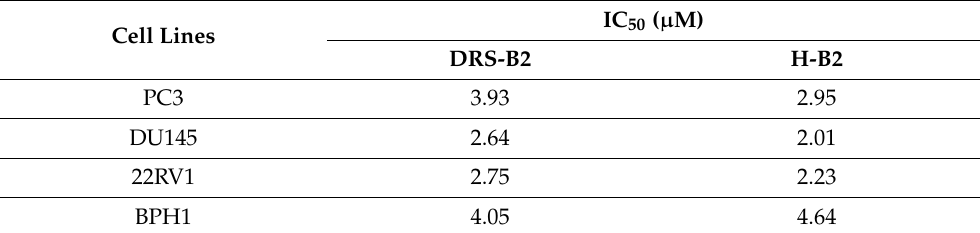
Table 2. Comparison of the IC 50 of H-B2 and DRS-B2 extracted from Figure 1, on the different cell